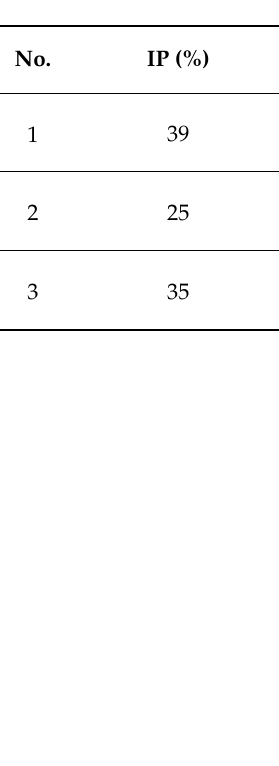
Table 8. Constraints of 3D input and output parameters .